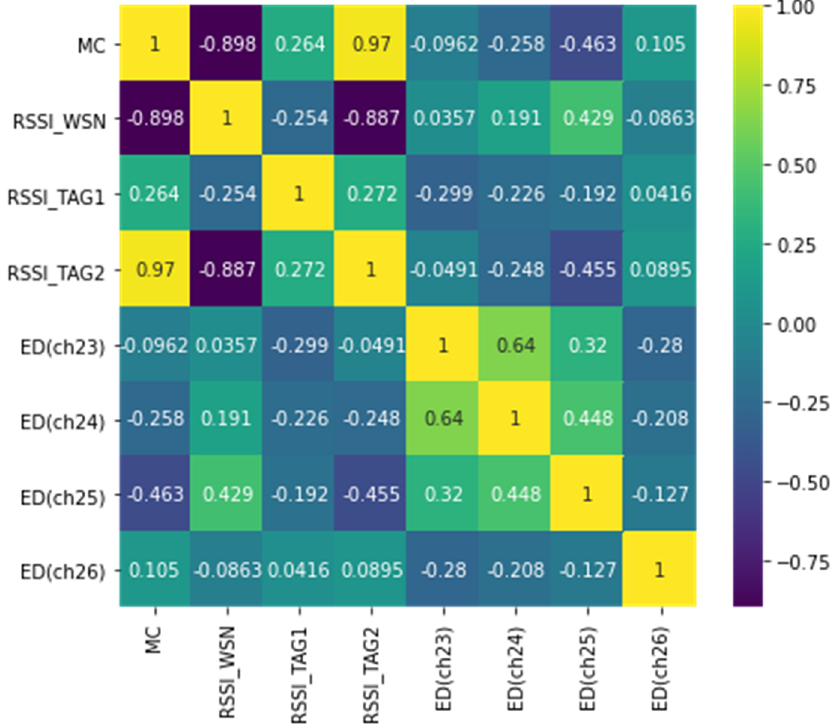
Figure 6. Correlation between different variables. MC represent Moisture Content; ED represents Energy Detection.